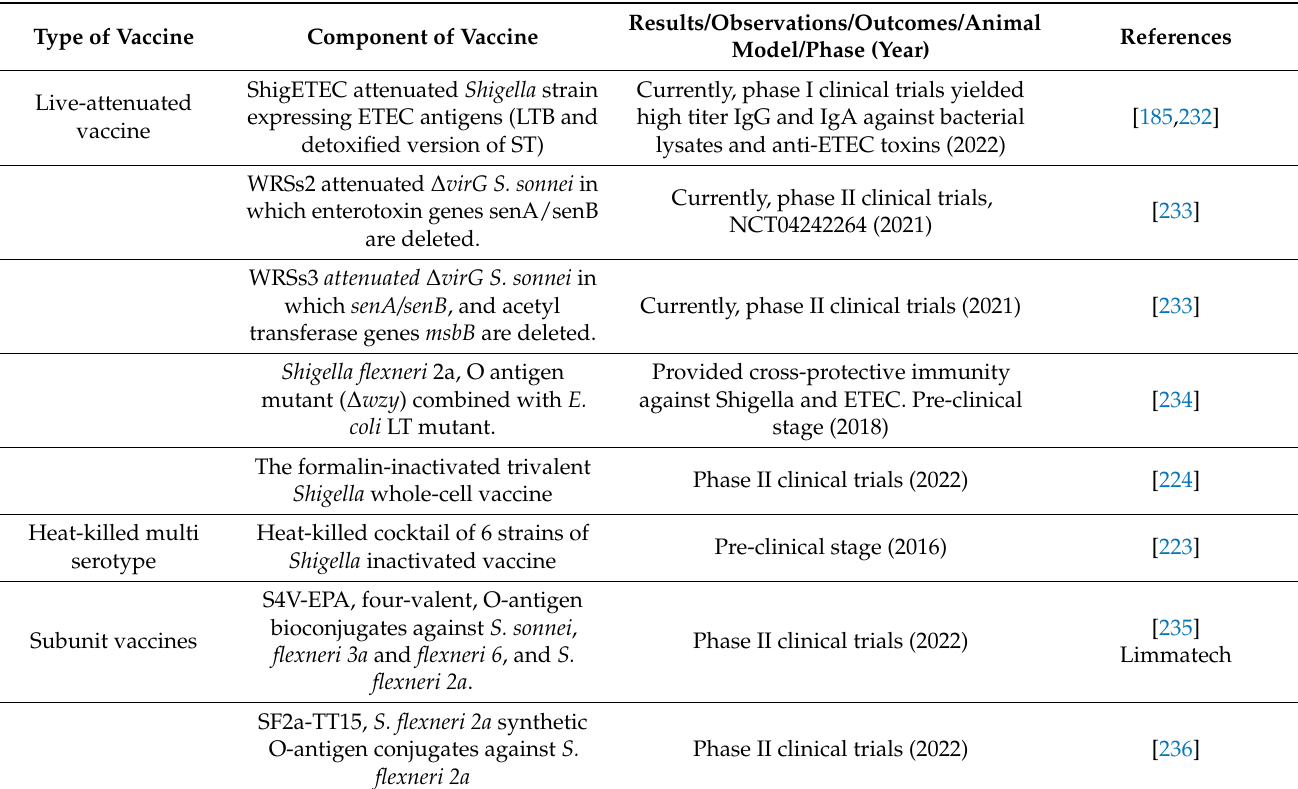
Table 4. Reports describing vaccines against Enteroinvasive E. coli (EIEC)/ Shigella